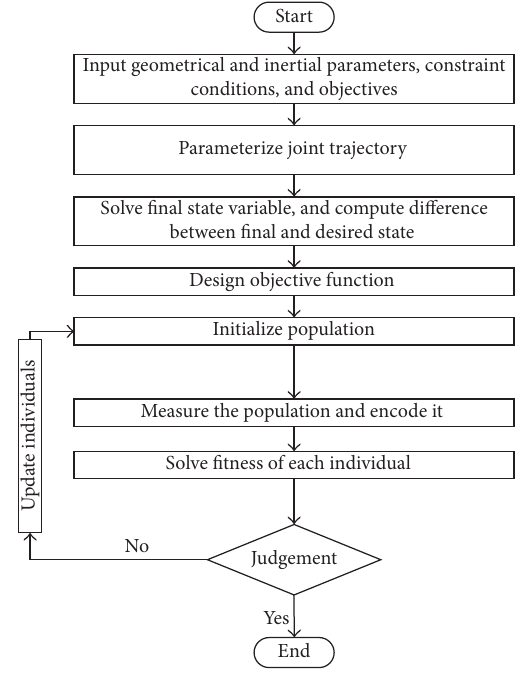
Figure 2: Flowchart of QGA.